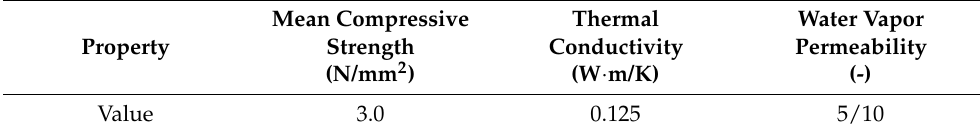
Table 2. Properties of the applied aerated concrete in block form.